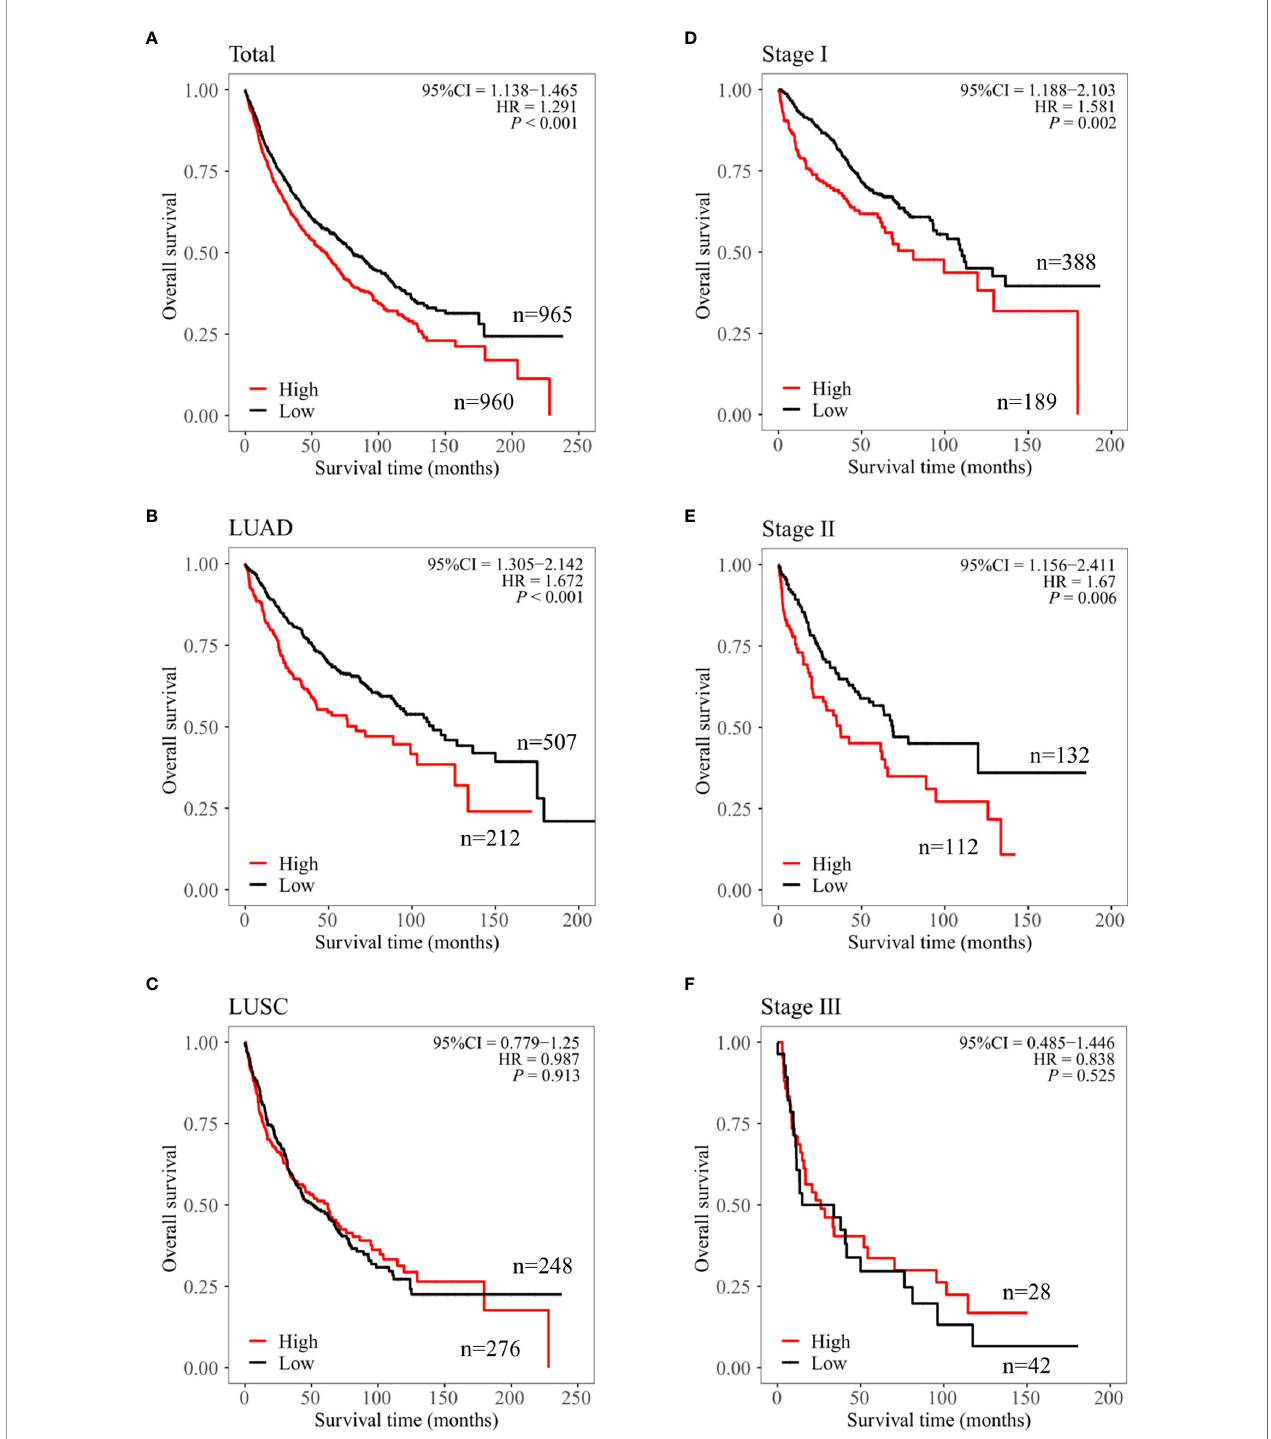
FIGURE 2 | CPN2 was associated with survival outcome in lung adenocarcinoma cancer from the Kaplan – Meier plotter. (A – C) Overall survival of CPN2 in the lung cancer (A) , lung adenocarcinoma ( B ), and lung squamous cell carcinoma (C) cohorts, respectively. (D – F) Overall survival plot of CPN2 in stage I (D) , stage II (E) , and stage III (F) in the lung adenocarcinoma cohort, respectively. Each group was divided according to the median expression cutoff value of CPN2 which equal to 24, and P < 0.05 was considered statistically signi fi